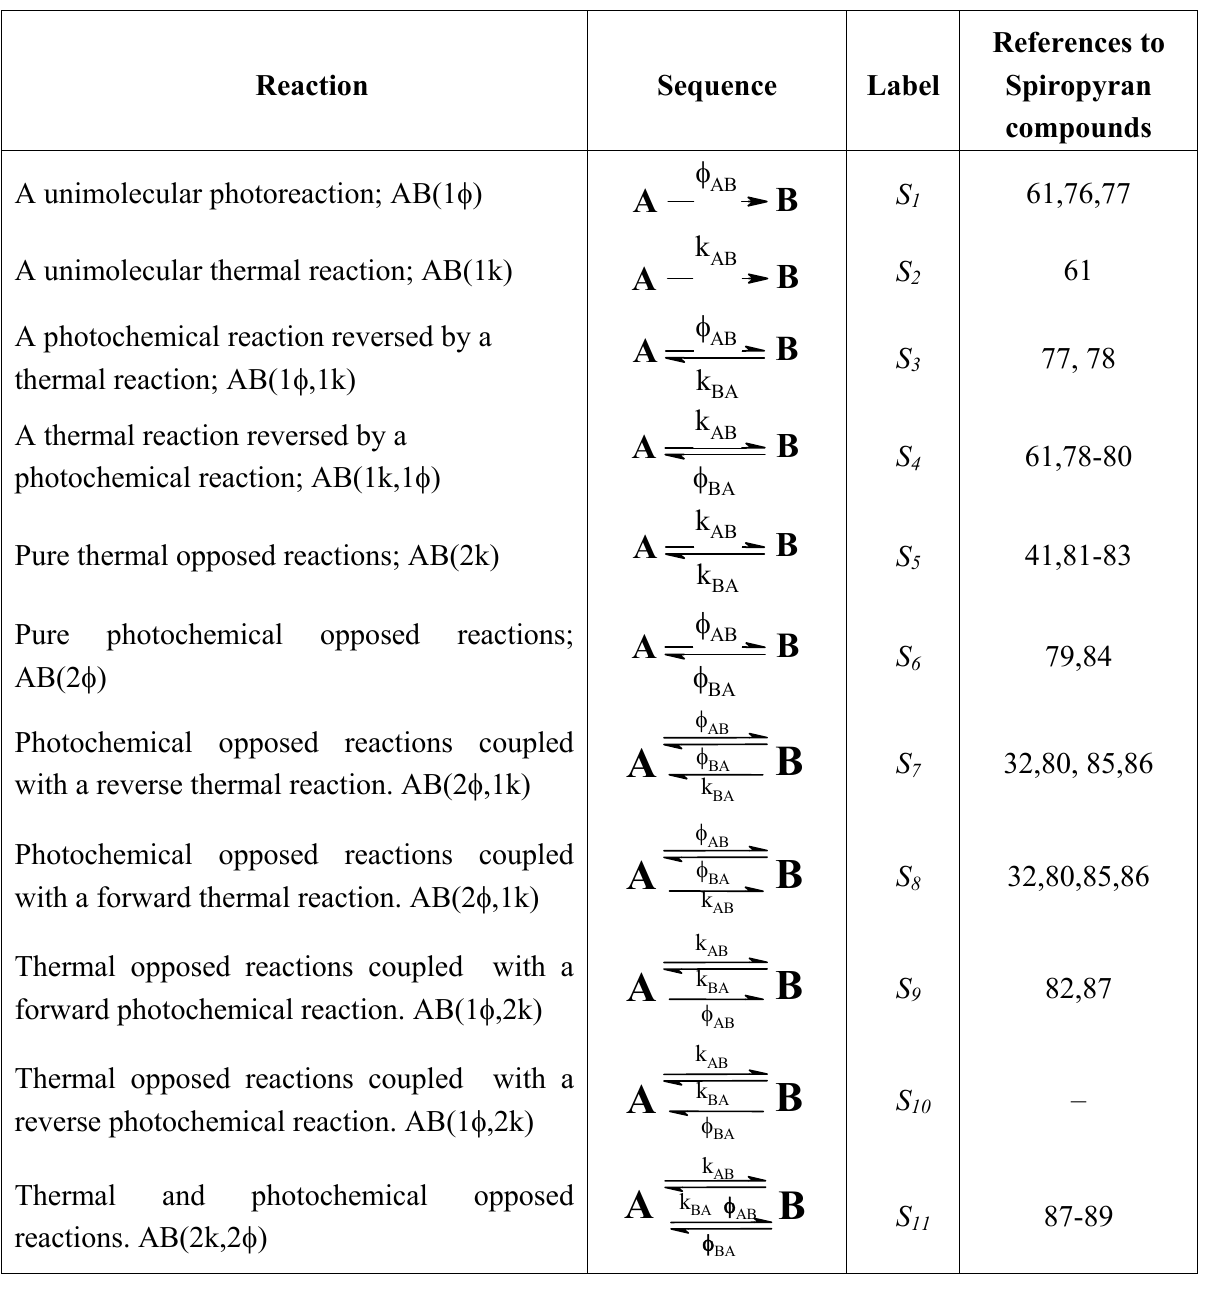
Table 1. Possible reaction schemes for AB